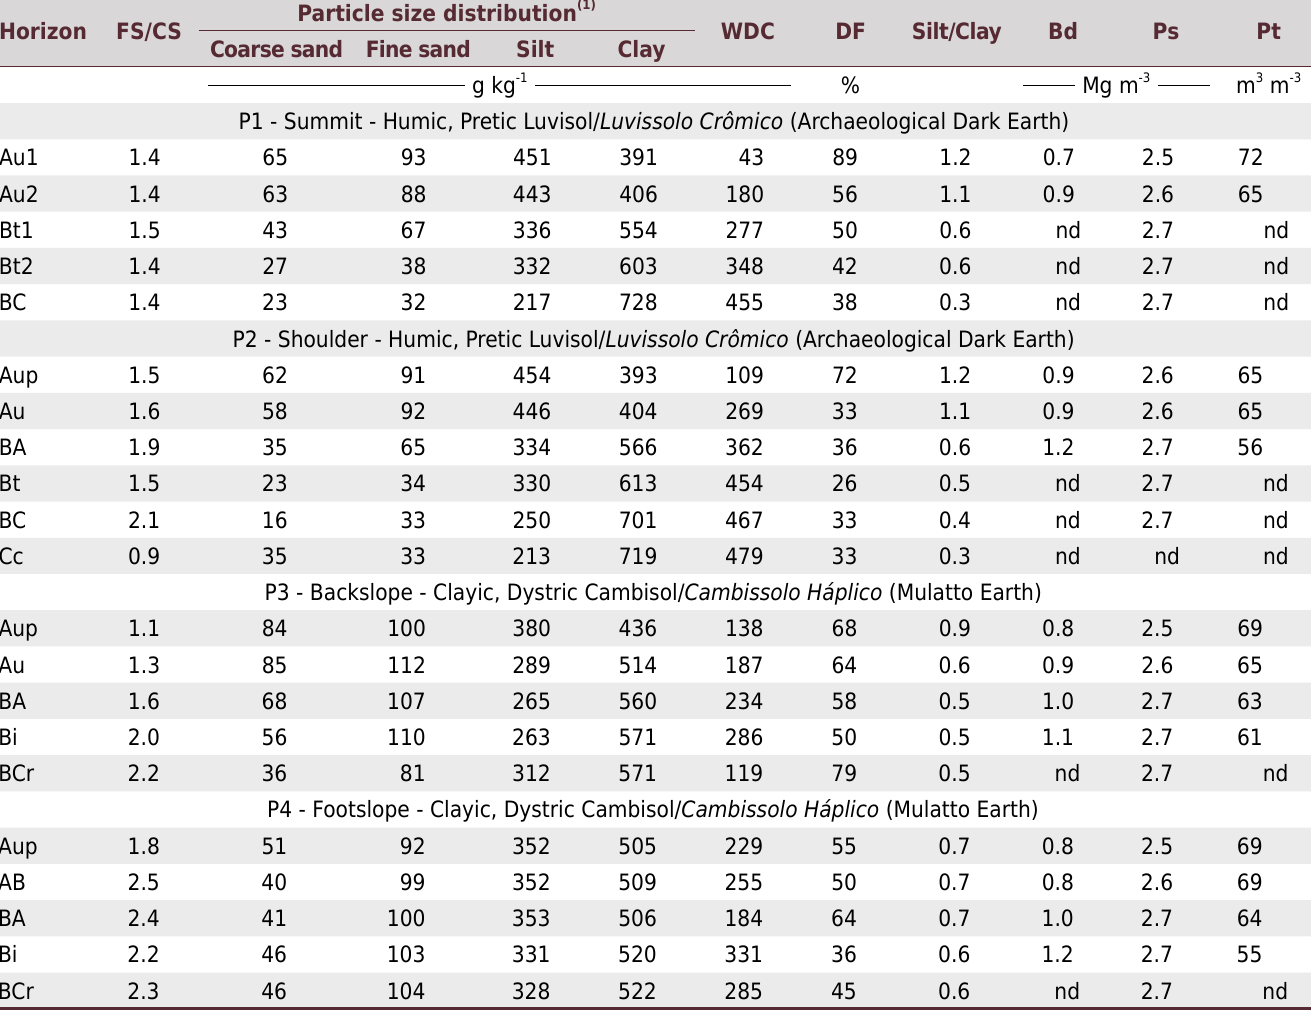
Table 2. Physical properties of Archaeological Dark Earth and Mulatto Earth in western Amazonia, Brazil Horizon FS/CS